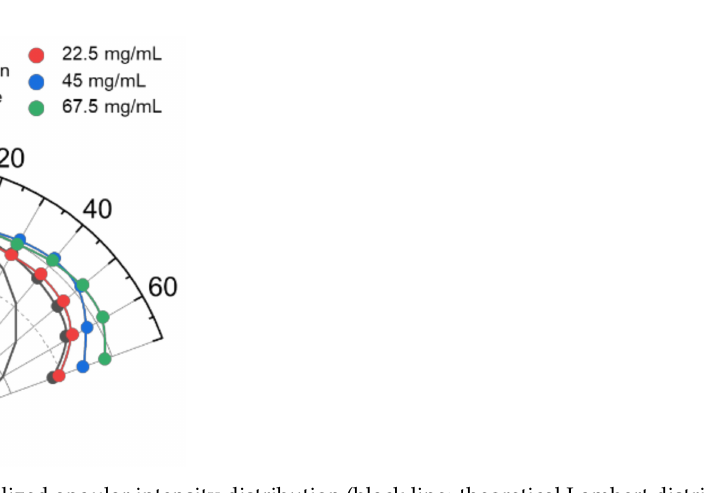
Figure 5. The normalized angular intensity distribution (black line: theoretical Lambert